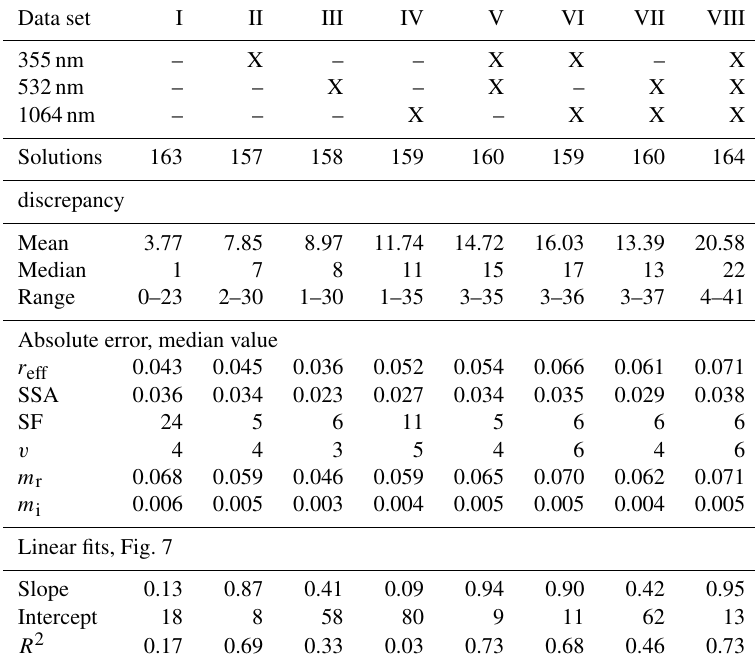
Table 2. Combinations of δ λ that were used as inversion input in addition to the conventional 3 + 2 data set (Set I), together with the mean number of averaged solutions, statistics on the considered discrepancies, and median absolute errors (from averaging of the considered solutions) of the retrieved effective radius ( r eff ), single-scattering albedo (SSA), spheroid fraction (SF), volume concentration ( v ), and real and imaginary part of the refractive index ( m r and m i ) for the respective input data sets. The bottom part of the table provides the slope, intercept, and squared correlation coefficients ( R 2 ) for the linear fits between dust ratio (as obtained with the method of Tesche et al., 2009b) and spheroid fraction presented in Fig.